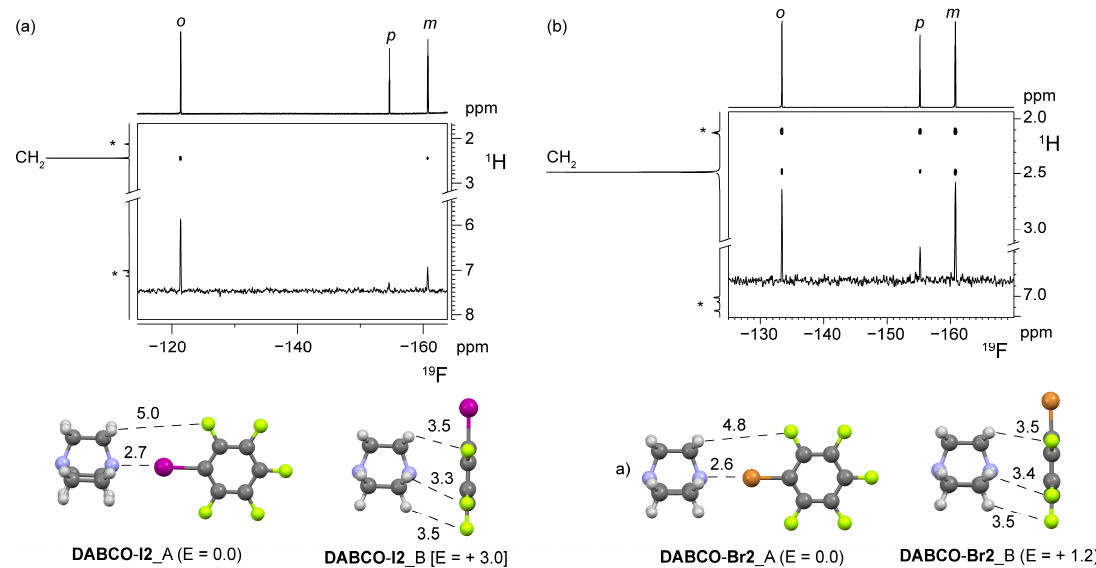
Figure 7. Adapted with permission from reference [61]. 19 F, 1 H HOESY NMR spectrum of a mixture of (a) DABCO and I2 and (b) DABCO and Br2. The trace is relative to the frequency of the -CH 2 -. Asterisks denote residual solvent peaks. Bottom: DFT-optimized geometries for DABCO / I2 and DABCO / Br2 adducts with relevant distances and relative energies [kcal mol − 1 , B3LYP-D3/TZVP level of theory]. Copyright 2015 Wiley-VCH Verlag GmbH & Co. KGaA.